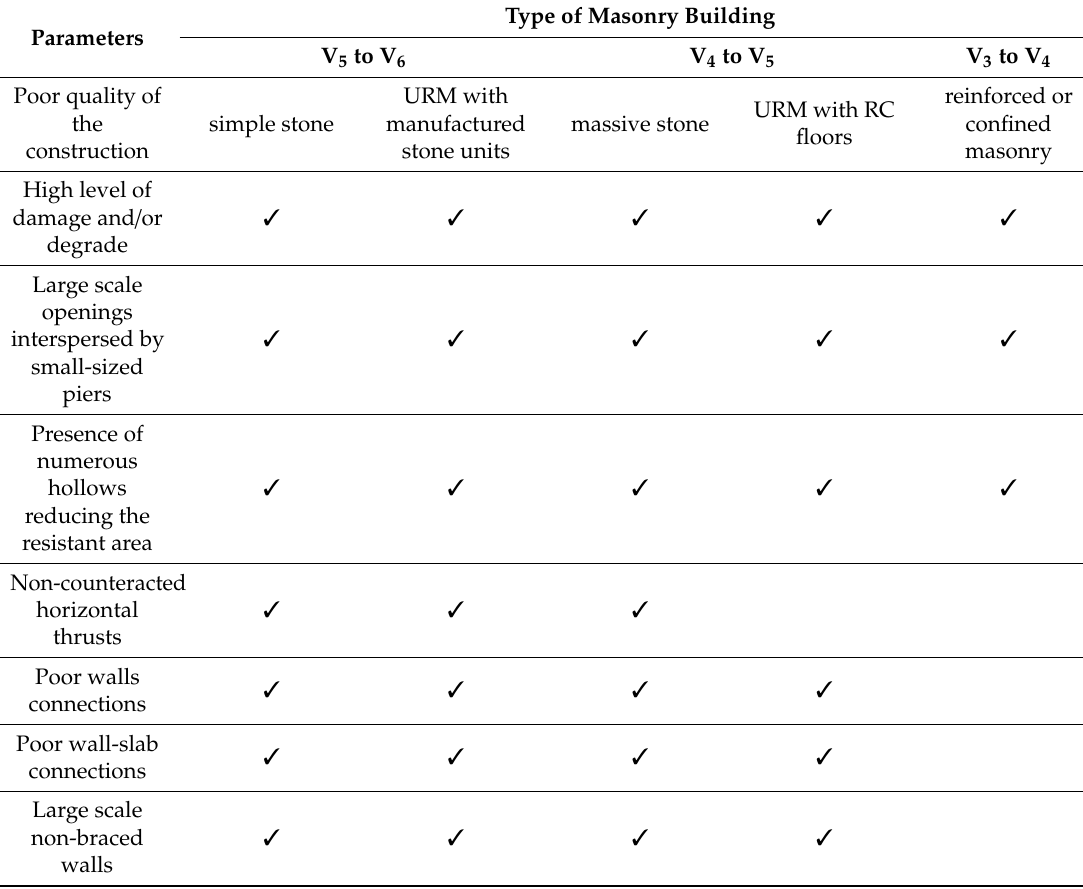
Table 4. Parameters for vulnerability class worsening provided by Italian guidelines DM 58 / 17